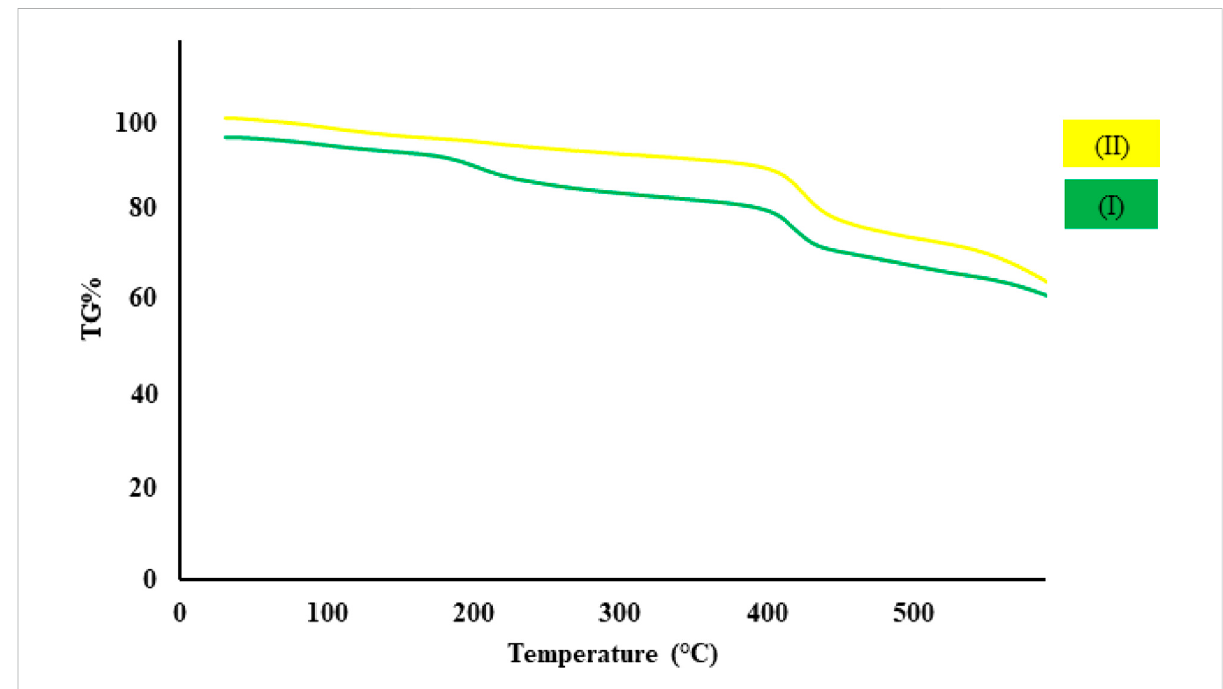
FIGURE 2 Thermal stability curve of synthesized cobalt composite (I) and CCPSF NPs (II).